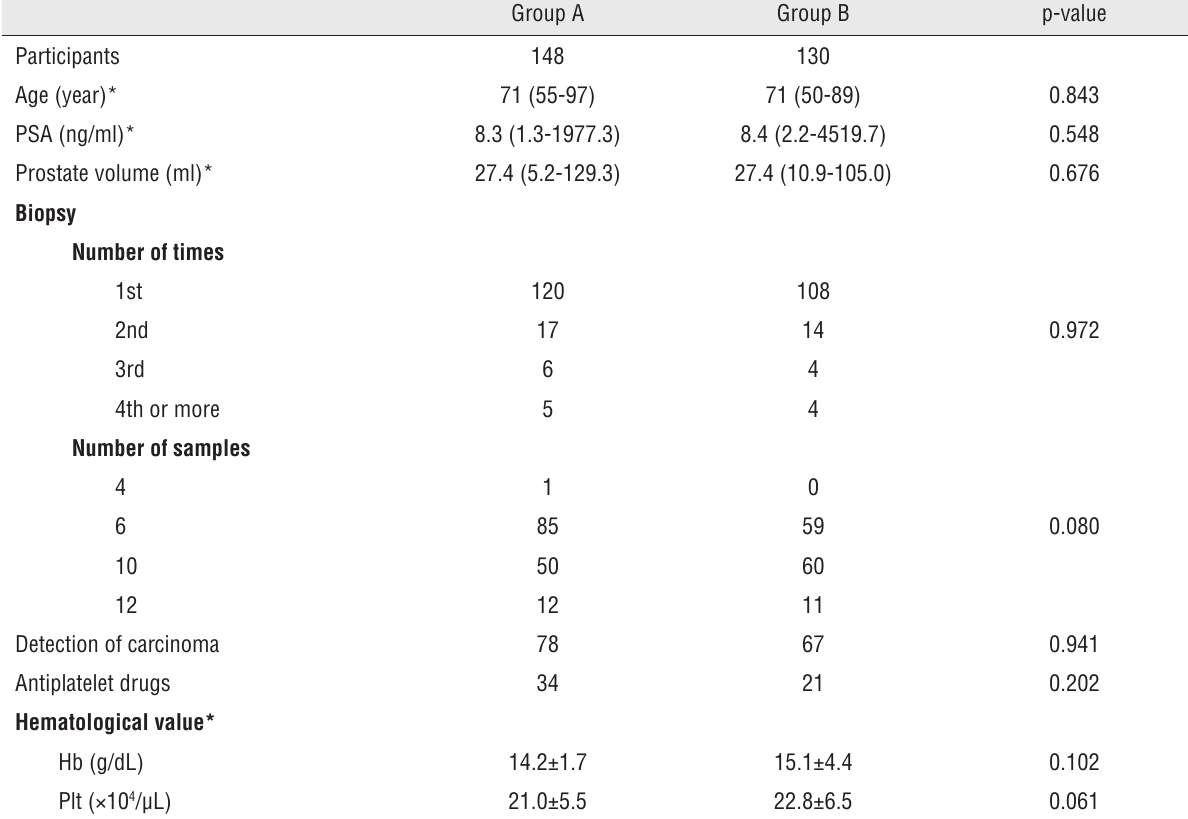
Table 1 - Participants’ background and hematological values in groups A and